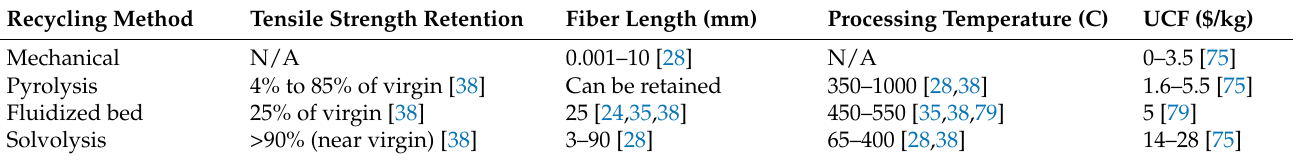
Table 3. Carbon fiber quality and cost of CFRP recycling